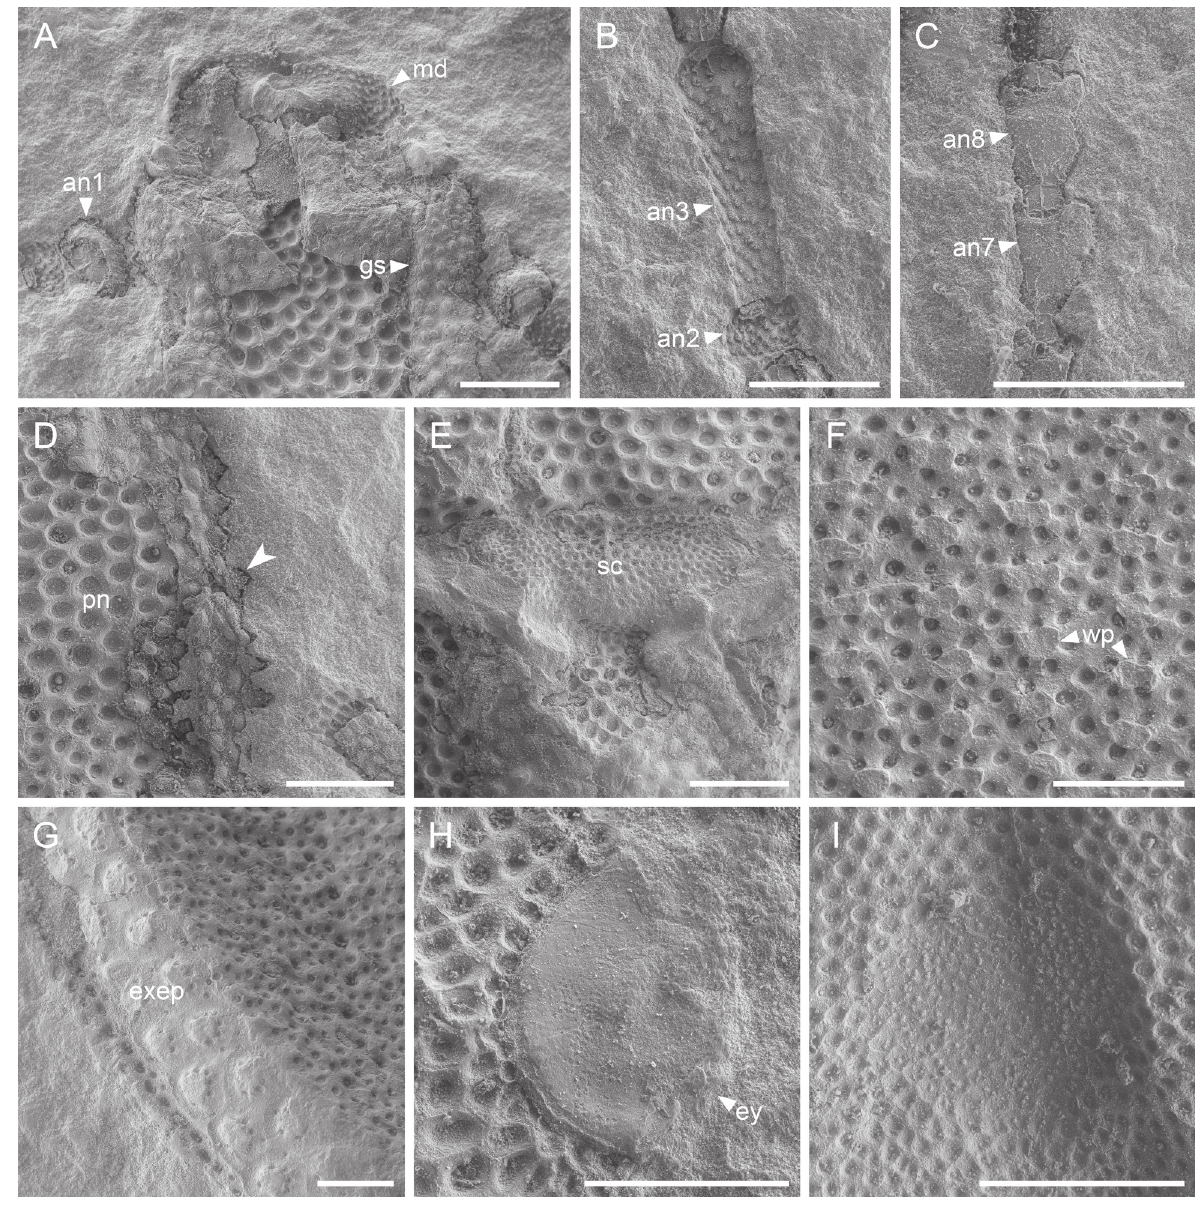
Figure 5. Details of Limnomma daohugouense gen. et sp. nov., holotype, NIGP176015, under scanning electron microscopy. A–G. NIGP176015a; A. Mouthparts; B. Antennomeres 2 and 3; C. Antennomeres 7 and 8; D. Dentate lateral edge of pronotal disc (arrowhead); E. Scutellum; F. Elytral disc; G. Explanate epipleuron; H–I. NIGP176015b; H. Compound eye; I. Non-tuberculate circular region on ventrite 5. Abbreviations: an1–8, antennomeres 1–8; exep, explanate epipleuron; ey, compound eye; gs, gula suture; md, mandible; pn, pronotum; sc, scutellum; wp, window punctures. Scale bars: 500